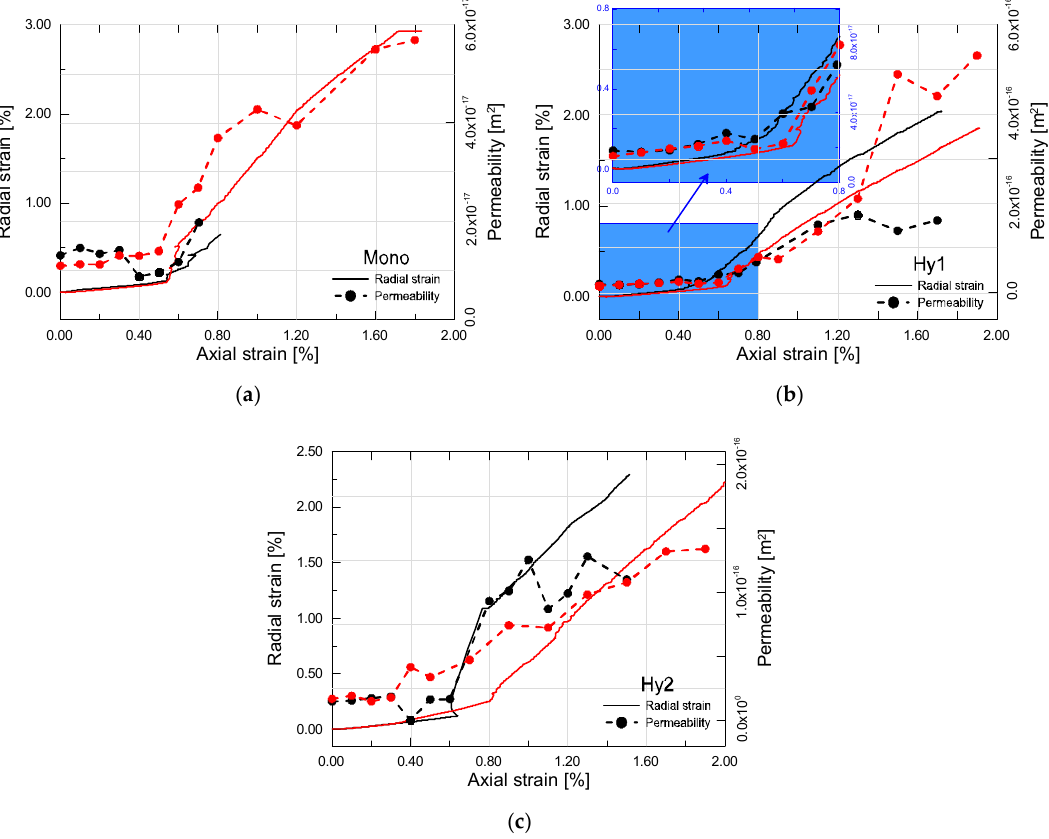
Figure 9. Permeability and radial strain evolution of ( a ) Mono, ( b ) Hy1 and ( c ) Hy2 in the process of compression test.